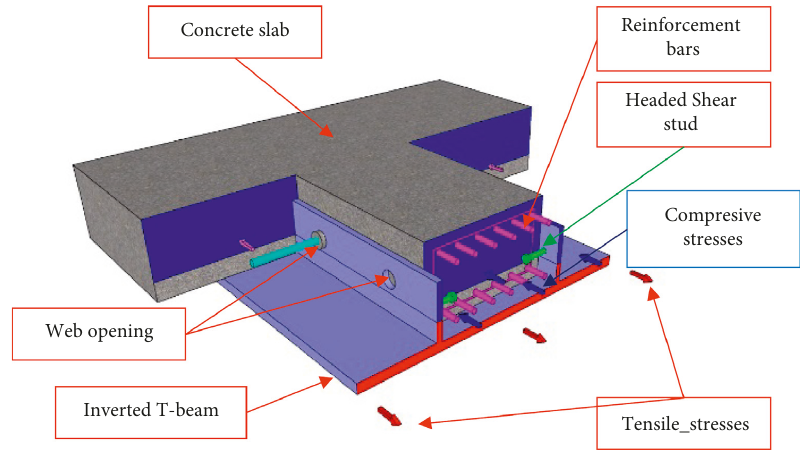
Figure 6: Composite slim floor with an inverted TT cross-sectional steel